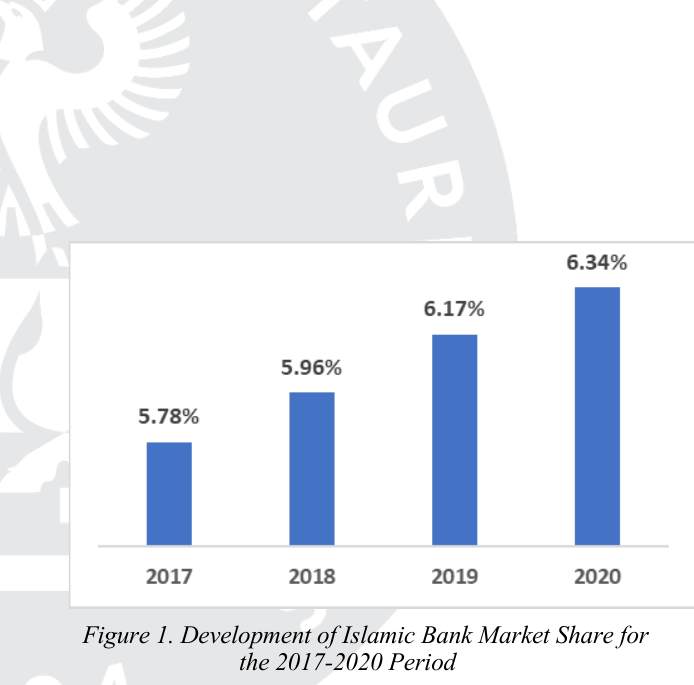
Figure 1. Development of Islamic Bank Market Share